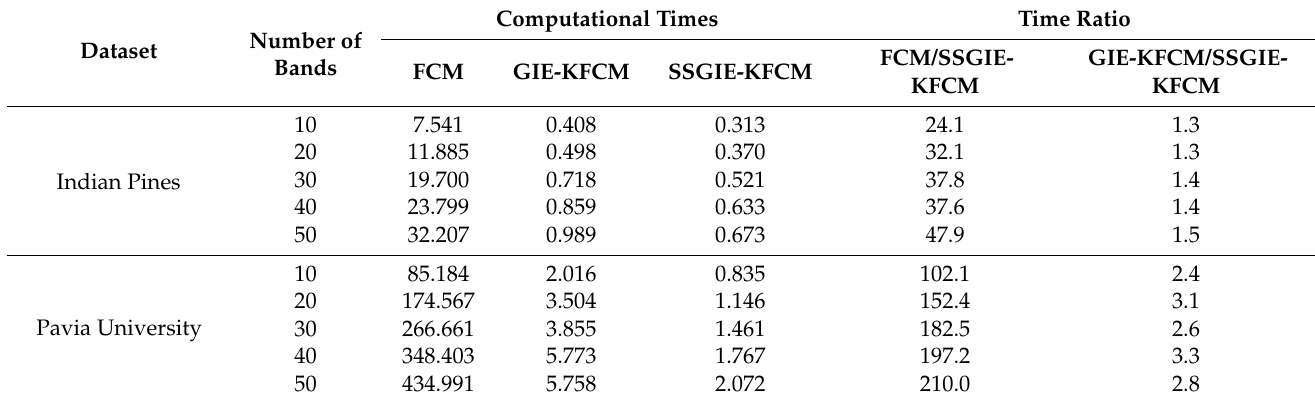
Table 6. Calculational time (in seconds) of different